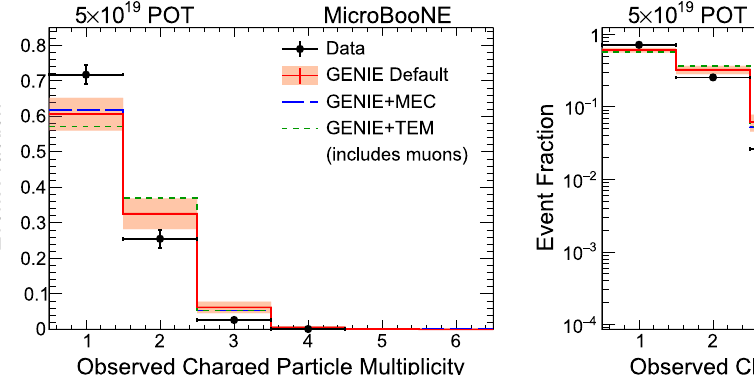
Fig. 11 Bin-by-bin normalized multiplicity distributions using 5 × 10 19 POT MicroBooNE data compared with three GENIE predictions (left) in linear scale, (right) in log scale. The data are CR background subtracted. Data error bars include statistical uncertainties obtained